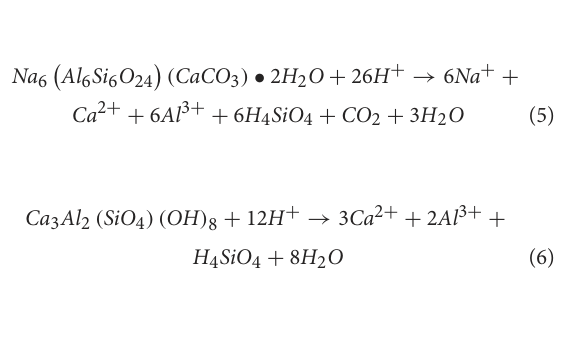
as perovskite [CaTiO 3 ], kassite [CaTi 2 O 4 (OH) 2 ], and